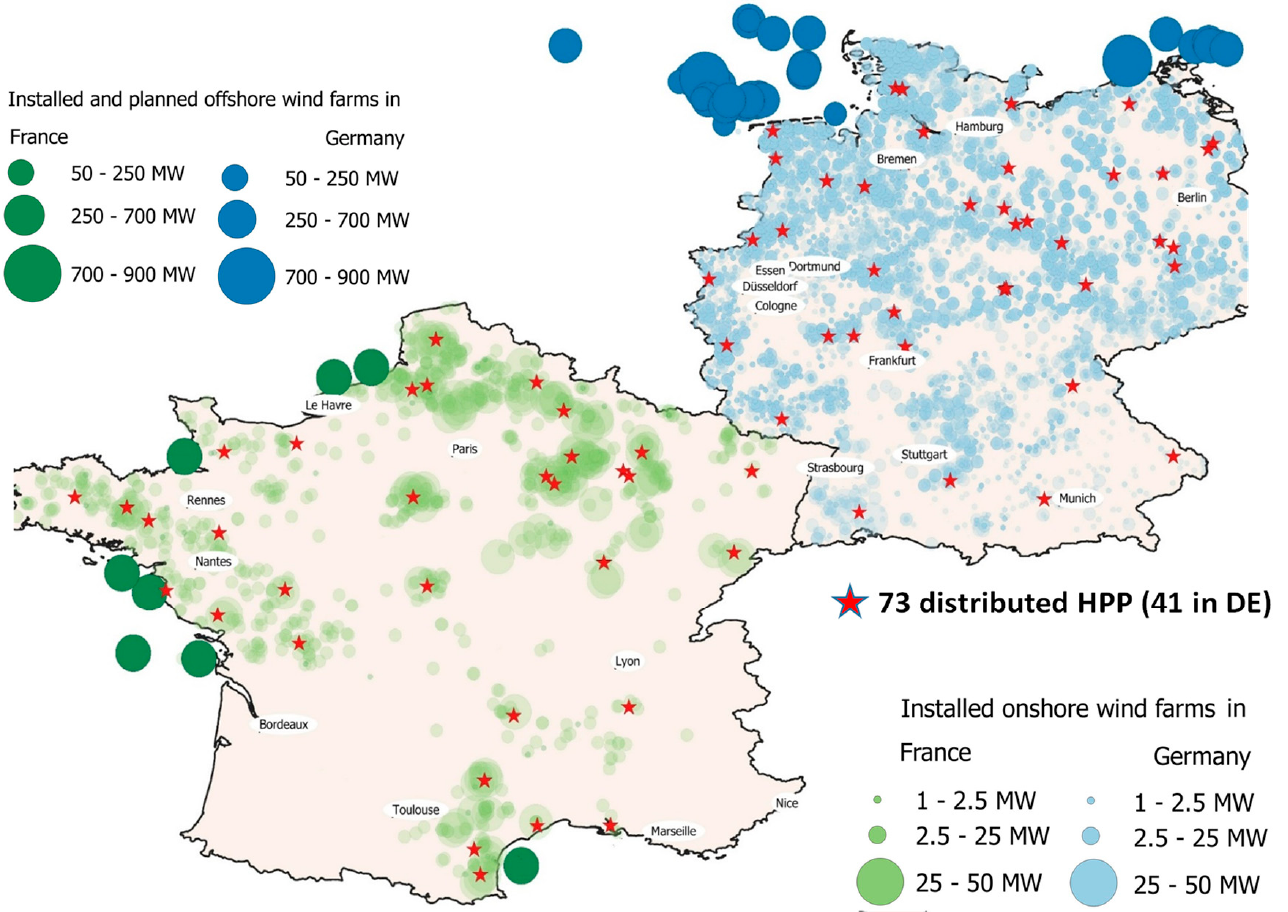
Figure 1. Location of wind farms and distributed hydrogen production plants (HPP). Changing the clustering methodology form narrow to wider allows defining a localized scenario with 22 HPP (12 in Germany).